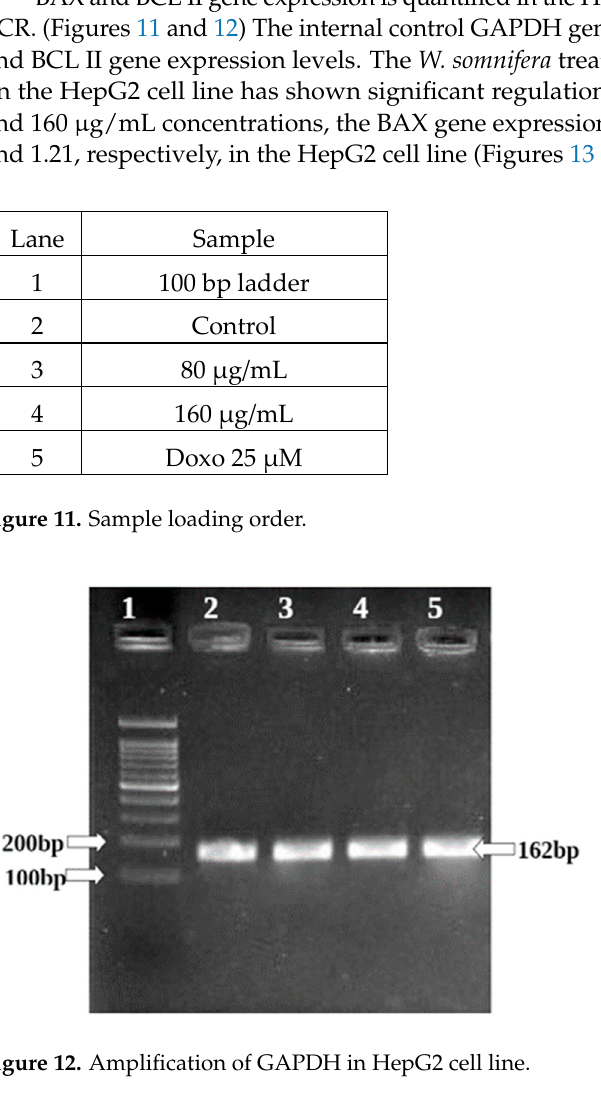
Figure 10. Flow cytometry analysis of apoptosis detection of HepG2 cells.